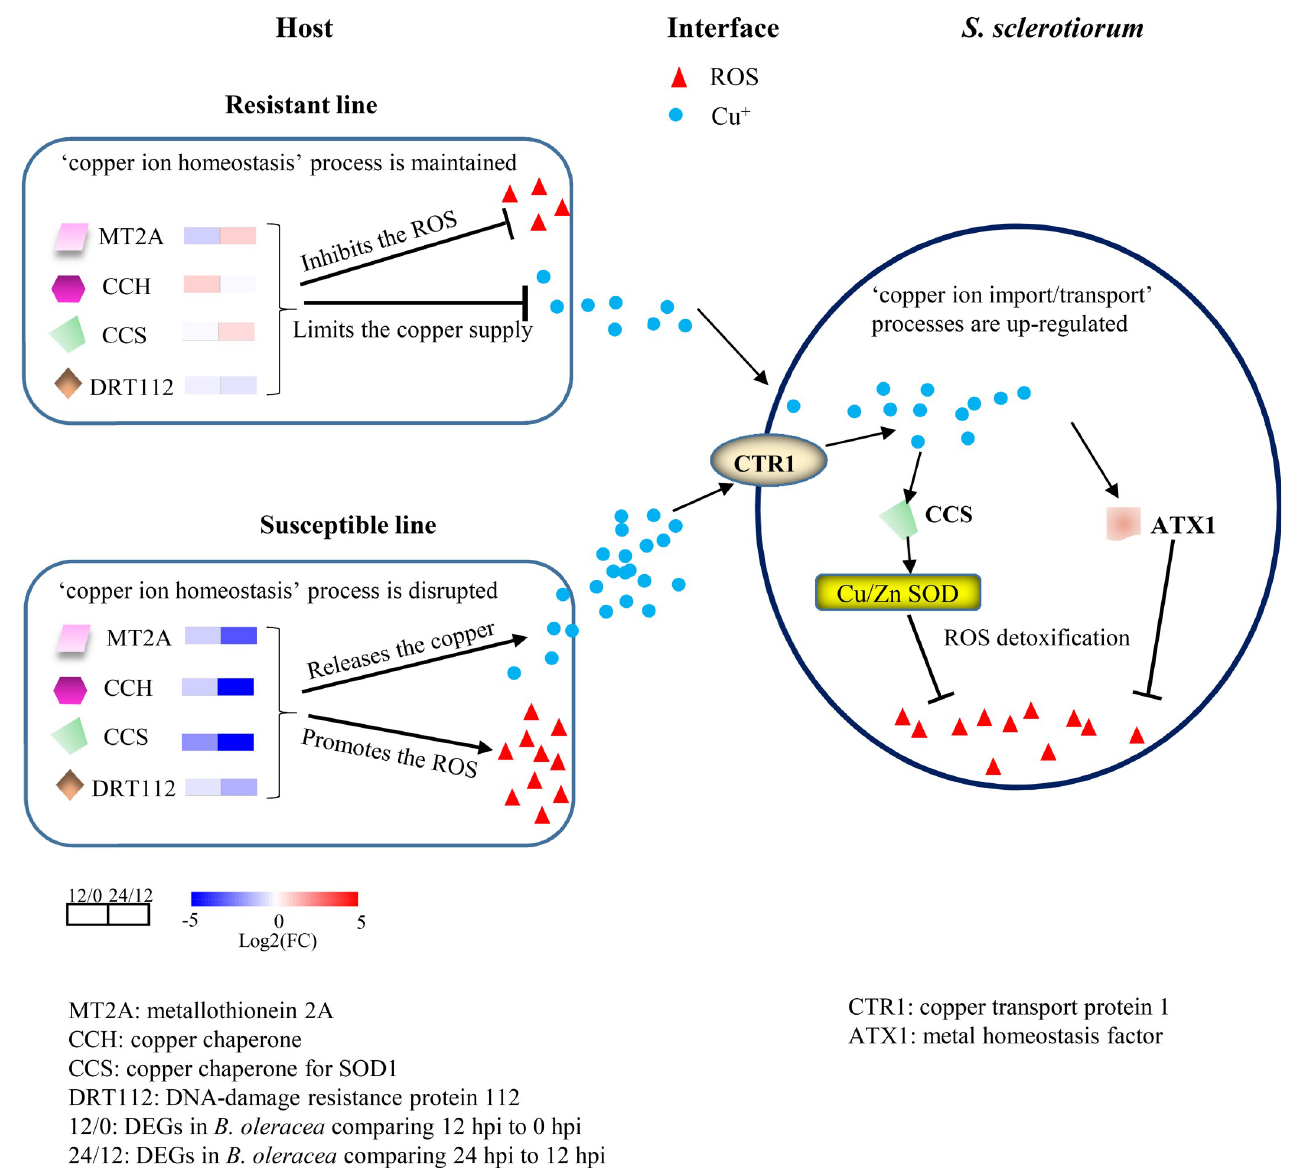
Fig 7. Model depicting the battle for copper acquisition between host and S . sclerotiorum during infection. S . sclerotiorum promotes its copper uptake systems to acquire host-derived copper, and activates its ROS scavenging system for survival and virulence, while a resistant host induces ‘nutritional immunity’ that restricts the supply of essential copper nutrients to S . sclerotiorum by maintaining ‘copper ion homeostasis’. 12/0: gene expression comparison of 12 hpi to 0 hpi in host, 24/12: gene expression comparison of 24 hpi to 12 hpi in